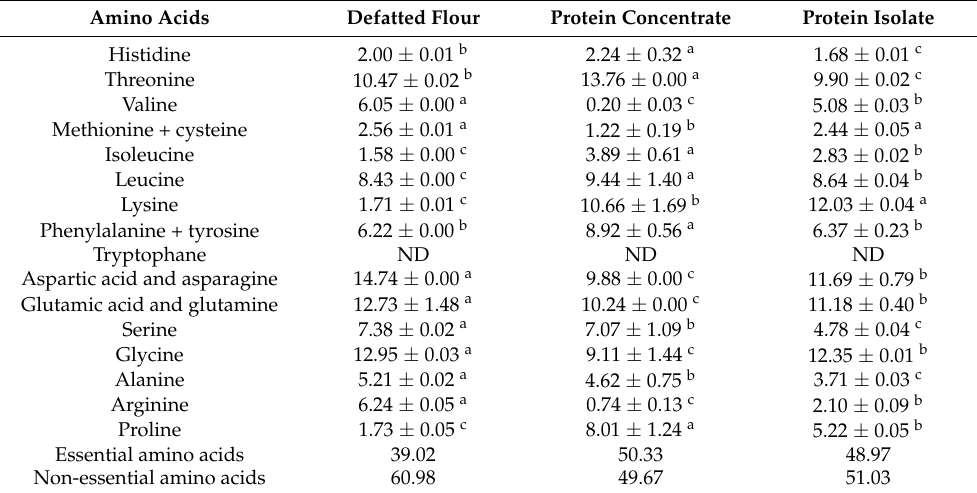
Table 6. Amino acid composition (g/100 g protein) of defatted flour, protein concentrate, and isolate of Macrotermes subhyalinus .